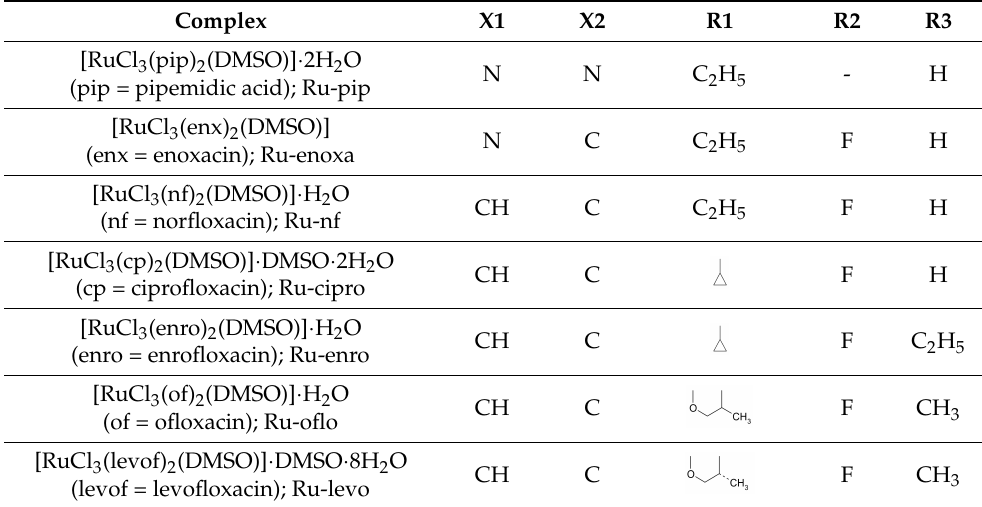
Table 1. Ruthenium (III) complexes with mixed ligands of the type RuCl 3 L 2 (DMSO) m · n H 2 O.